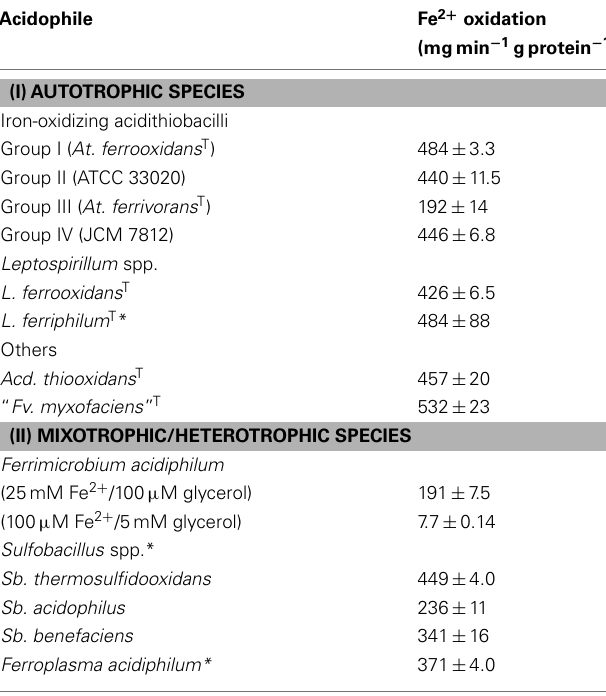
Table 2 | Specific rates of ferrous iron oxidation determined for different species of acidophilic bacteria and the archaeon Ferroplasma